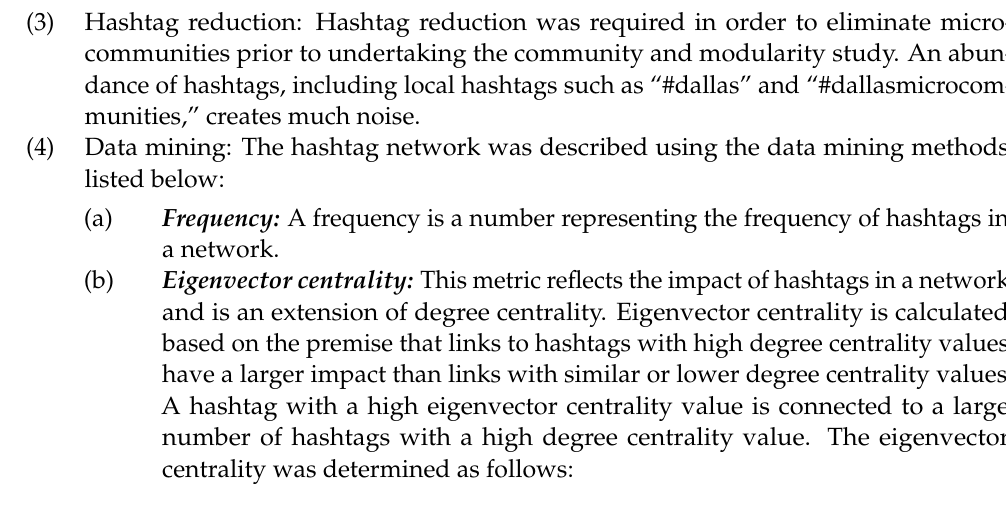
Figure 2. Community visualization in the area of food blogger on Twitter.